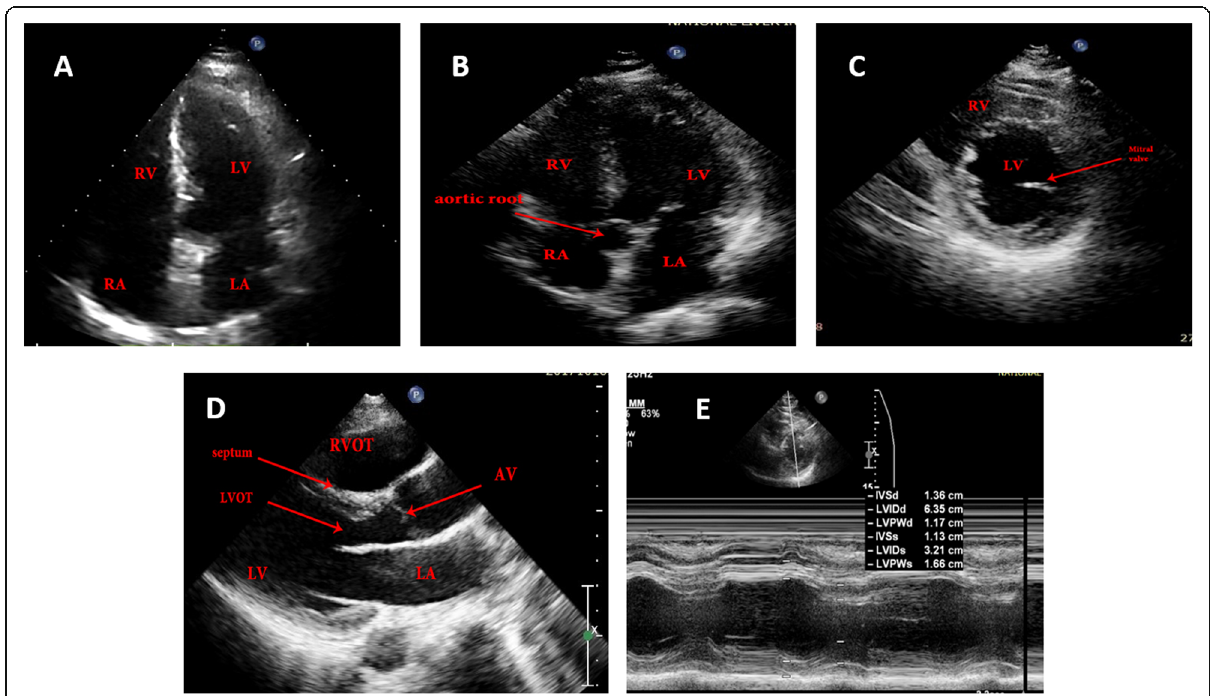
Fig. 2 Echocardiography technique. a 2D echocardiography; apical 4-chamber view. b 2D echocardiography; apical 5-chamber view. c 2D echocardiography; parasternal short-axis view. d 2D echocardiography; parasternal long-axis view. e 2D echocardiography short-axis left parasternal view of the heart with M mode measurements of the interventricular septal thickness, left ventricular diameter, and left ventricular posterior wall thickness during systole and diastole (RV, right ventricle; LV, left ventricle; RA, right atrium; LA, left atrium; RVOT, right ventricular outflow tract; LVOT, left ventricular outflow tract; AV, aortic valve; IVSd, interventricular septum thickness at end-diastole; LVIDd, left ventricular internal diameter in diastole; LVPWd, left ventricular posterior wall thickness at end-diastolic; IVSs, interventricular septum thickness at end-systole; LVIDs, left ventricular internal diameter at end-systole; LVPWs, left ventricular posterior wall thickness at end-systole)